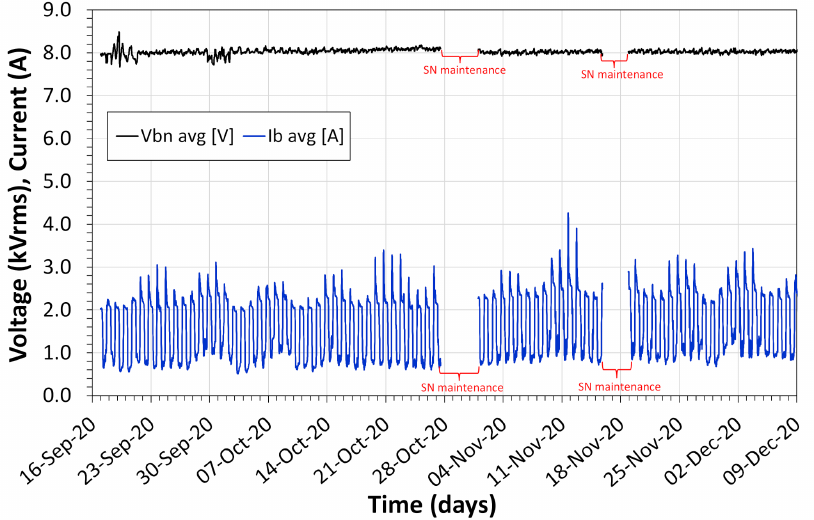
Figure 17. Voltage and current data obtained during almost 3 months in the field test of the sensor in the advanced